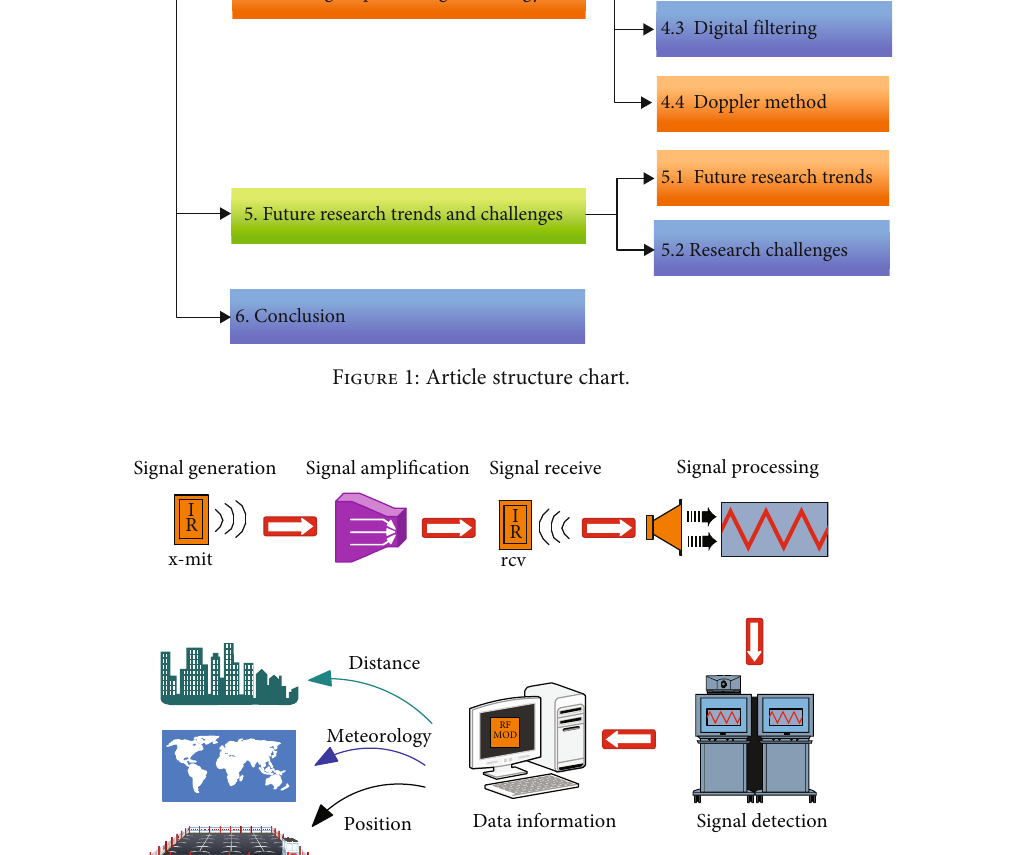
Figure 2: Radar signal transmission process.